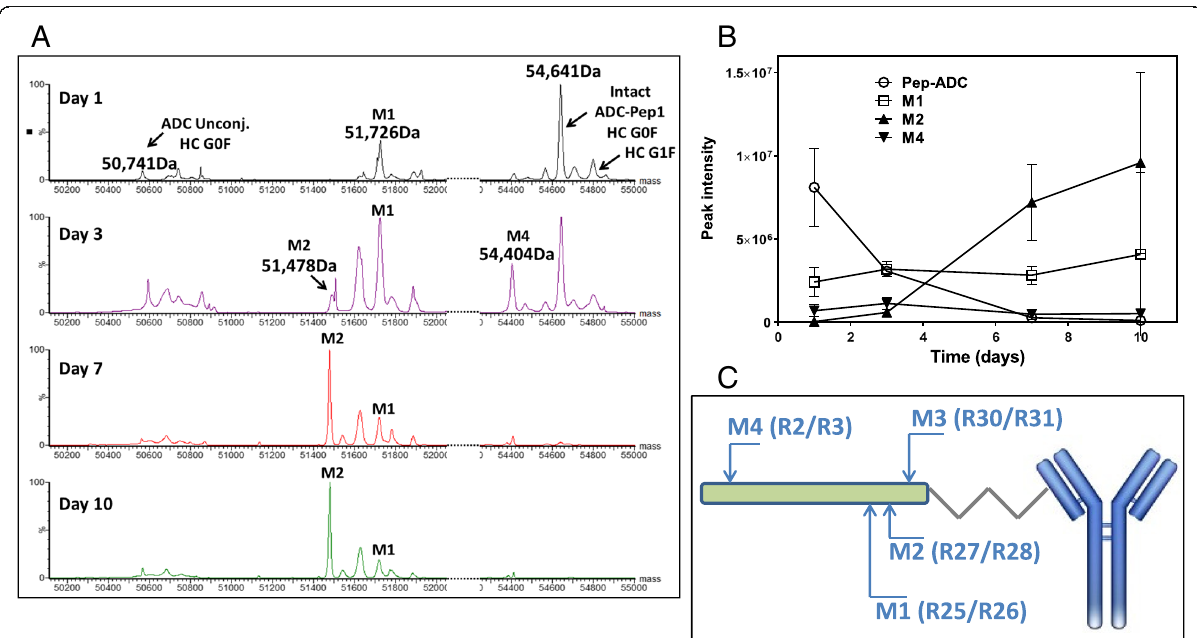
Fig. 9 Intact mass analysis of Pep-ADC in mice by AP-LC-MS. Pep-ADC (3 mg/kg) administered to C57BL/6 J diet induced obese (DIO) mice by IV was retrieved by pull-down for intact mass analysis on a Synapt G2S Q-TOF. Intact mass profiles show the appearance of several metabolites named M1, M2, and M4 (Panel a ). Panel b shows the relative abundance of each species up to 10 days post-dosing. Data plotted are mean peak intensity from four mice per time point. Error bars correspond to the S.D. calculated using GraphPad Prism 7. Error bars shorter than the symbols are not plotted. Panel c indicates the sites of cleavages on the peptide that matches with